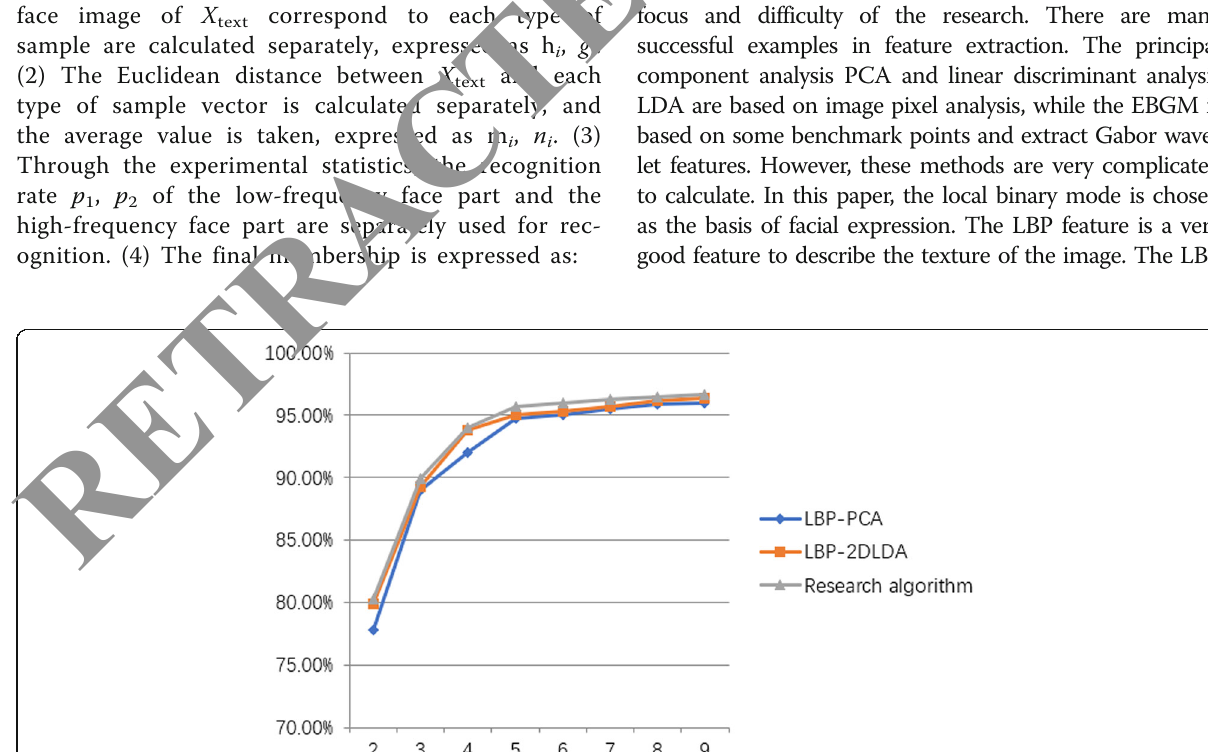
Fig. 1 Line diagram of face recognition rate for different